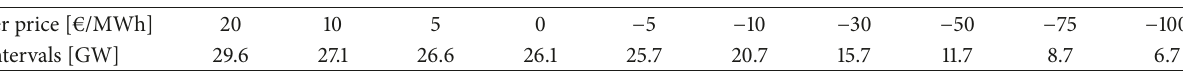
Table 5: Associated residual loads, RL, and wholesale power prices according to analysis of market situations with low (0–20 €/MWh) and negative ( < 0€/MWh) prices in Germany 2011 [15, 16].